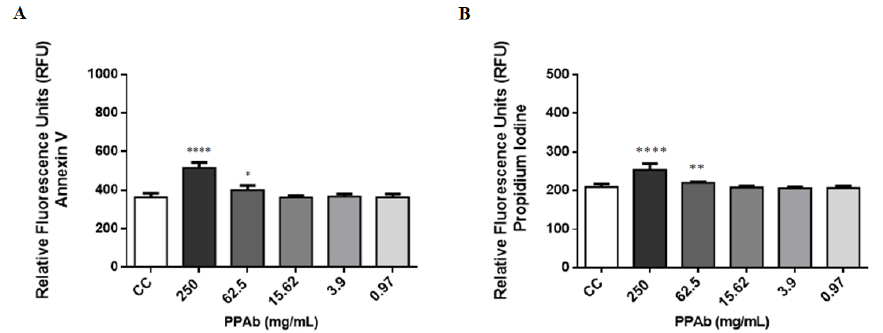
Figure 6. Cytoplasmic membrane asymmetry and DNA fragmentation exerted by the PPAb on human intestinal C2BBe1 cells. Polarized C2BBe1 cells were exposed to different concentrations of PPAb at 37 °C and 5% CO 2 for 24 h. Cells were stained with the ApoDETECT™ kit (Invitrogen™) and analyzed by fluorometry. ( A ) Phosphatidylserine in the outer layer of cell membrane (Annexin V). ( B ) DNA fragmentation (Propidium Iodide). CC: cell control (non-PPAb treated cells). Experiments were done in triplicates and repeated independently three times. Bars represent mean ± SD. * p < 0.05, ** p < 0.01, **** p < 0.0001; unpaired Welch’s t -test for comparisons with the CC control.